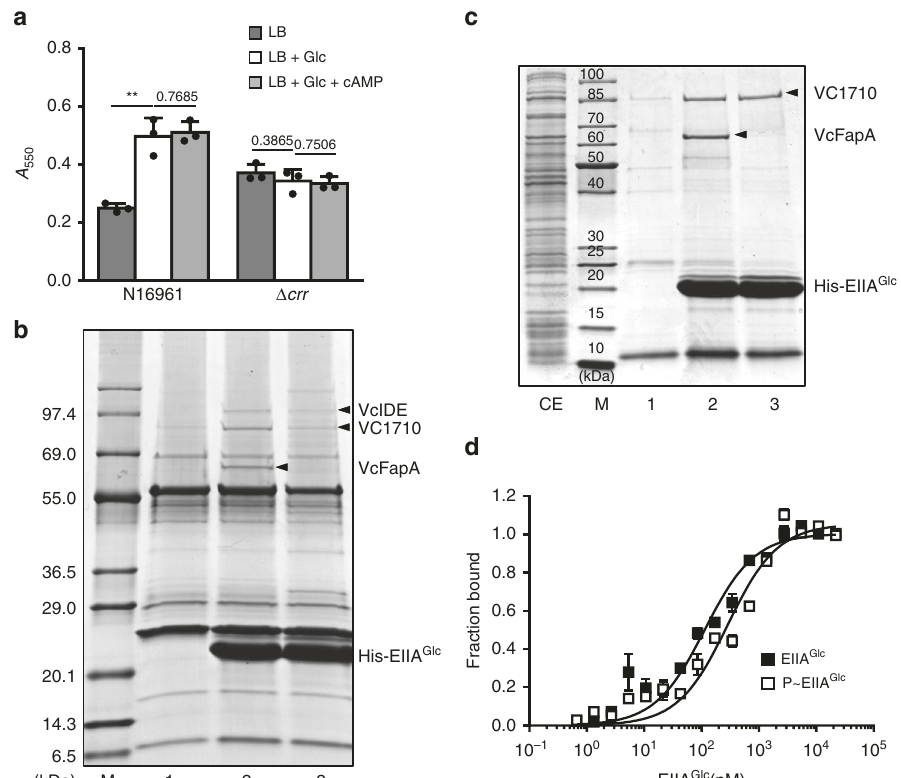
Fig. 1 Speci fi c interaction of VC1710 with EIIA Glc . a The bio fi lm-forming activity of wild-type V. cholerae N16961 and an otherwise isogenic Δ crr mutant was measured in LB alone or supplemented with glucose or glucose and cAMP, as indicated. Bio fi lm formation was assessed following the static growth of V. cholerae cells for 23 h using a crystal violet staining method 61,62 . The stained bio fi lm formation was determined at 550 nm. Statistical signi fi cance was assessed using Student ’ s t -test ( p -values > 0.05 were presented, ** p -value < 0.01). Shown are the means and SD ( n = 3, independent measurements). b Ligand fi shing experiment was carried out to fi nd proteins interacting with His-EIIA Glc . Crude extract prepared from V. cholerae O1 biovar El Tor N16961 cells was mixed with buffer A (lane 1) or 100 μ g of puri fi ed His-EIIA Glc (lanes 2 and 3). The extract containing His-EIIA Glc was supplemented with either 2 mM glucose to dephosphorylate EIIA Glc (lane 2) or 2 mM PEP to phosphorylate EIIA Glc (lane 3). Each mixture was subjected to TALON metal af fi nity chromatography and proteins bound to the column were analyzed as described in the “ Methods ” section. c A mixture of E. coli cell lysates expressing recombinant VC1710 and VCA1085 ( V. cholerae FapA) (lane CE) was mixed with buffer A or His-EIIA Glc and subjected to TALON metal af fi nity chromatography as in panel b . d The binding af fi nities of VC1710 with either dephosphorylated (black square) or phosphorylated EIIA Glc (white square) were measured using NanoTemper Monolith NT.115 pico . The dissociation constants ( K d ) of VC1710 complexed with dephosphorylated and phosphorylated EIIA Glc (P~EIIA Glc ) were obtained from three technical replicates. Shown are the means and SD ( n = 3, independent